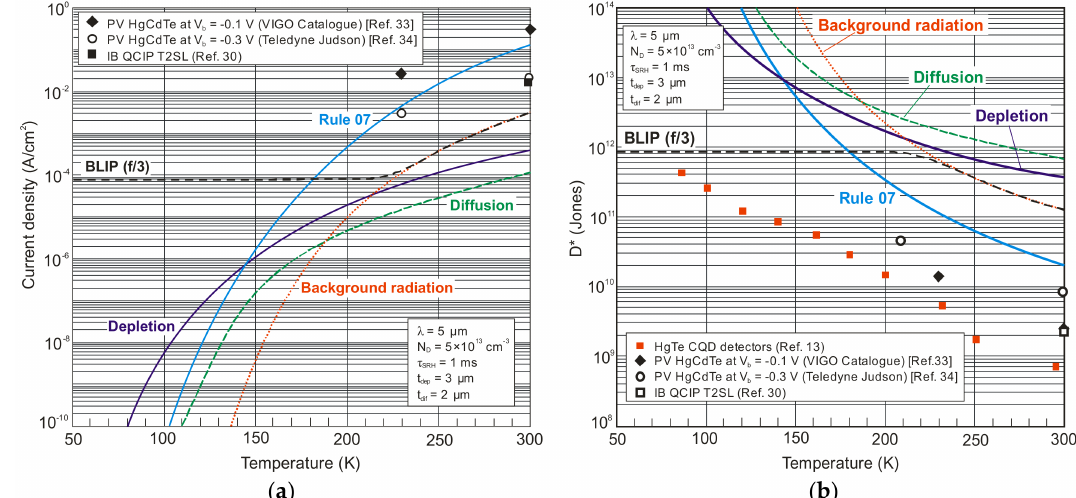
Figure 7. MWIR P-i-N HgCdTe photodiode performance with τ SRH = 1 ms and absorber doping 5 × 10 13 cm − 3 : ( a ) diffusion and depletion current components versus temperature, ( b ) detectivity versus temperature. The thickness of active region: t = 5 µ m and consists of t dif = 2 µ m and t dep = 3 µ m. The experimental data is taken from different sources as marked. PV— Photodiode, CQD—Colloidal quantum dot, IB QCIP—Interband quantum cascade infrared photodetector. Experimental data is taken from